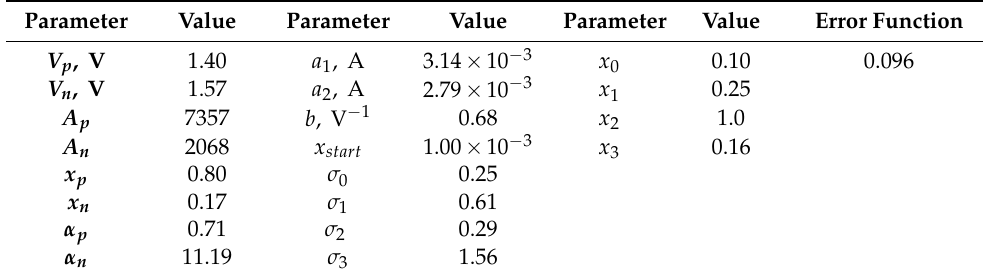
Figure 7. Approximation results: ( a ) model VAC [17]; ( b ) corresponding potential function. Table 1. Optimal parameters of the analyzed model with normalized symmetric difference area as error function.